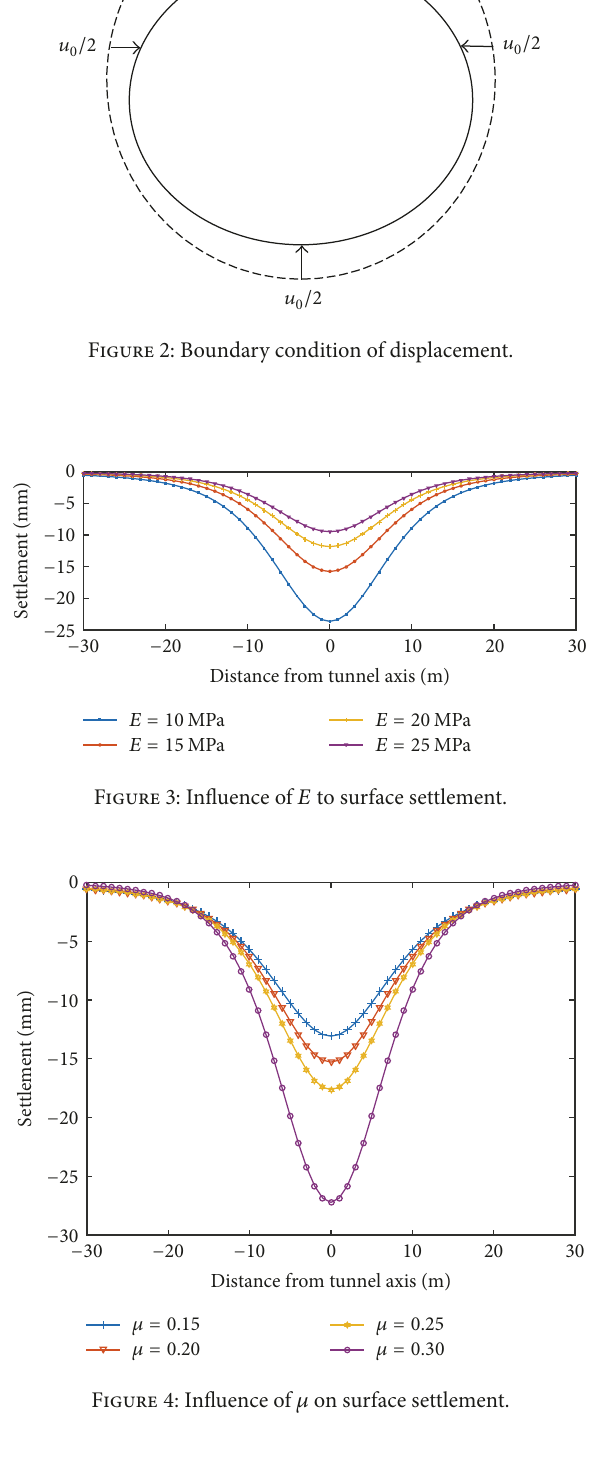
foundation underpinning, or the affected building body reinforcement [14].